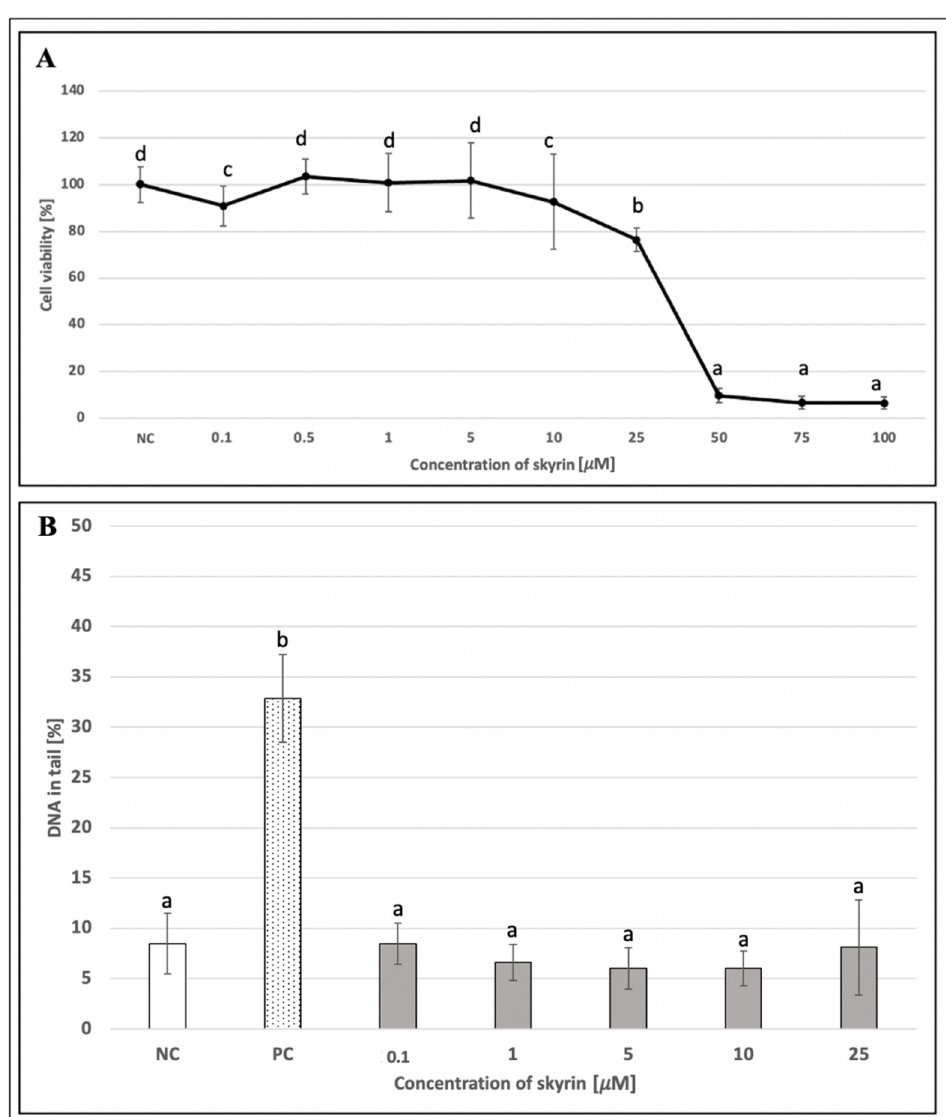
Figure 8. Evaluation of the potential cytotoxic ( A ) and genotoxic ( B ) effects of skyrin (SK) on the HepG2 cell line (24 h treatment followed by washing step and 24 h recovery period) at different concentrations using the MTT and the comet assays. Negative control (NC)—untreated cells; positive control for comet assay (PC)—cells treated with 1 mM hydrogen peroxide. Results were analyzed by ANOVA single-step multiple comparisons of means using LSD tests, and comparisons between the mean values were considered significant at p < 0.05. Similar letters represent samples with no statistically significant differences between them. All experimental data in this work are from at least three independent experiments.